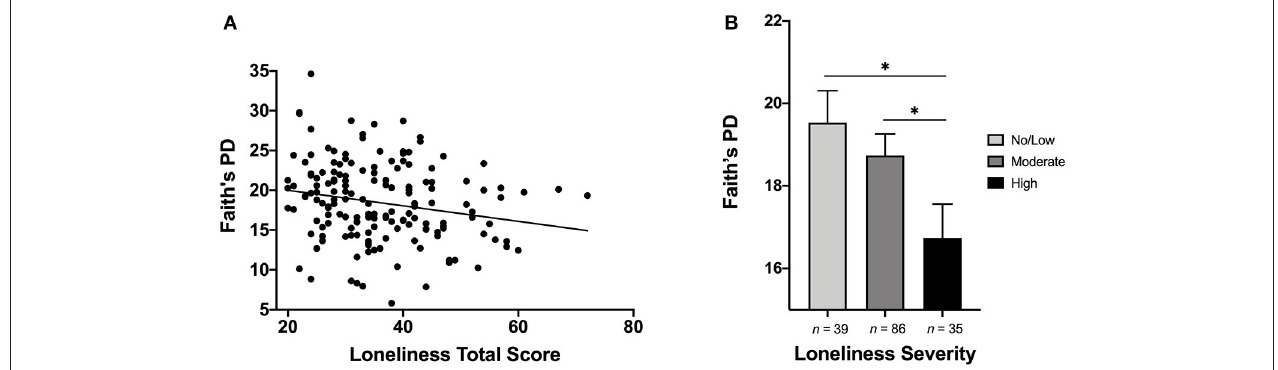
FIGURE 1 | (A) Scatterplot depicting the relationship between loneliness and alpha-diversity (Faith’s Phylogenetic Diversity). Higher level of loneliness was associated with significantly lower alpha-diversity. (B) Bar plot illustrating differences in alpha-diversity based on loneliness severity categories. Individuals with High levels of loneliness exhibited significantly lower gut microbial alpha-diversity, compared to those with No/Low and Moderate levels of loneliness. * p or q < 0.05.